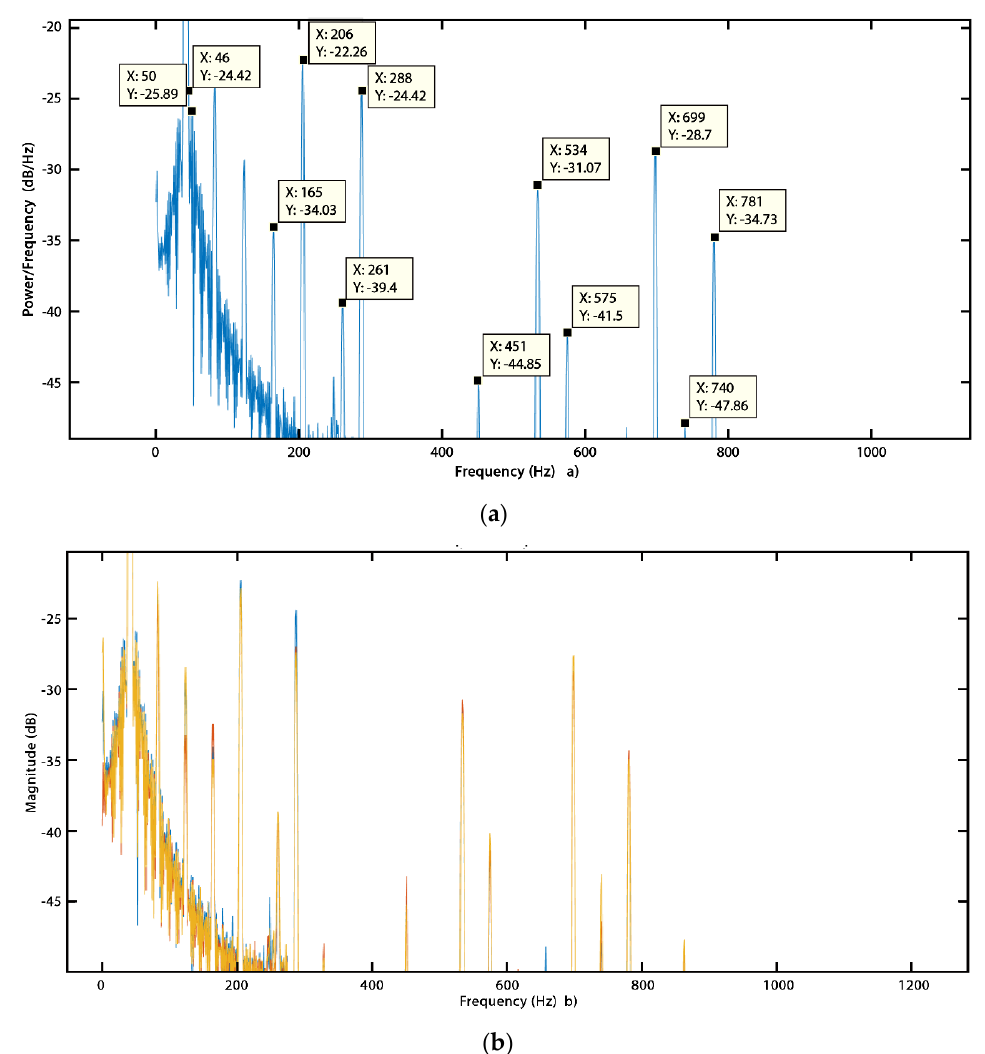
Figure 3. PSD applying Welch's periodogram. ( a ) Phase A and ( b ) three phases.